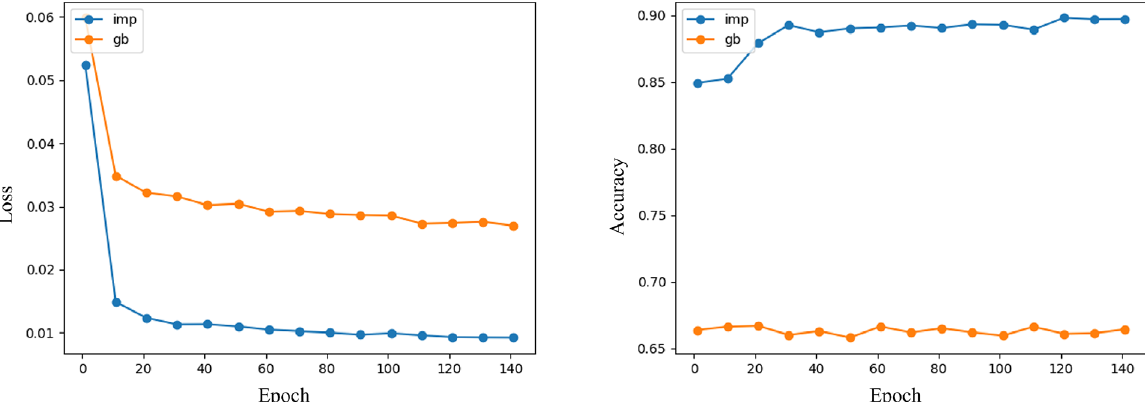
(a) Training loss. Impurities Segmentation in blue, GB (b) Training accuracy. Impurities Segmentation in blue, GB segmentation in orange. segmentation in orange. Figure 5. Training loss and accuracy of the segmentation